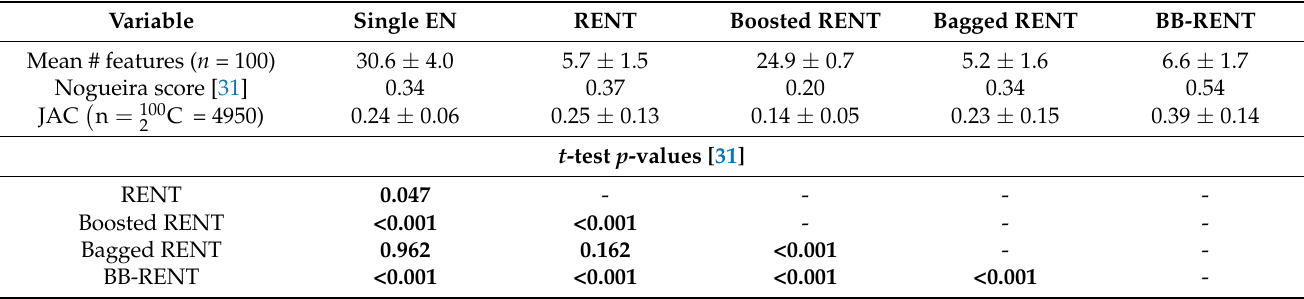
Table 5. Feature selection stability in terms of Nogueira score [31] and Jaccard index (JAC) of the five feature selection methods. Whereas boosting and bagging used separately with RENT resulted in worse or similar stability, combing them into BB-RENT led to significantly improved stability. All pairwise comparisons for JAC between the five configurations showed significant differences.